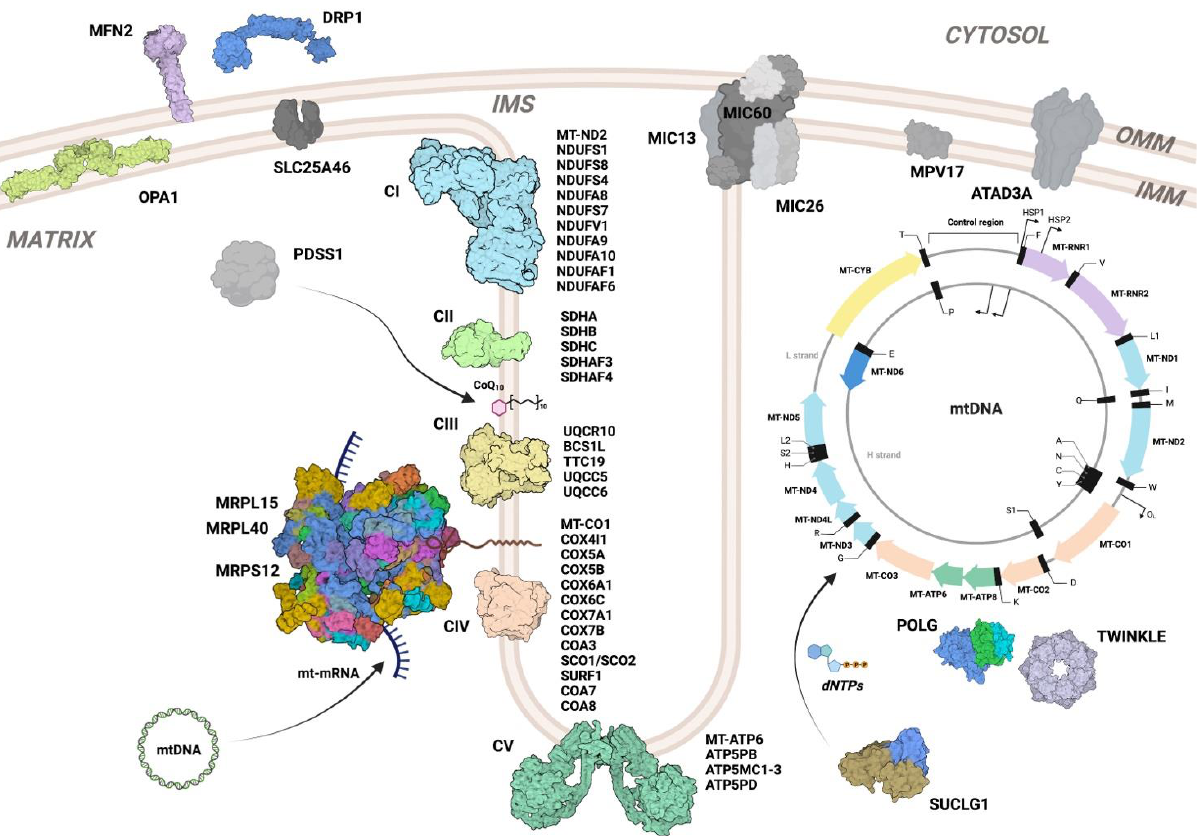
Figure 3. Mitochondrial proteins and complexes for which D. melanogaster models are currently available. D. melanogaster models of mitochondrial diseases include defects in OXPHOS subunits and assembly factors (listed in Table 1), defects in mtDNA maintenance (i.e., mtDNA replication machinery, nucleoid structure, and dNTP synthesis (POLG, TWINKLE, SUCLG1, MPV17, and ATAD3A)), disorders affecting mitochondrial gene expression (mitoribosomal proteins MRPS12, MRPL15, and MRPL40), and disorders affecting mitochondrial dynamics and architecture (OPA1, DRP1, MFN2, SLC25A46, and MICOS components MIC60, MIC26/27, and MIC13). Proteins are depicted using mammalian protein structures retrieved from the following PDB IDs: complex I (5LC5), complex II (1ZOY), complex III (1BGY), complex IV (2OCC), complex V (7AJD), mitoribosome (7A5F), POLG (3IKM), Twinkle (7T8C), SUCLG1 (1EUC), s-OPA1 (6QL4), MFN2 (6JFK), and DRP1 (3ZVR). No structural data are available for the proteins depicted by generic shapes in grey.